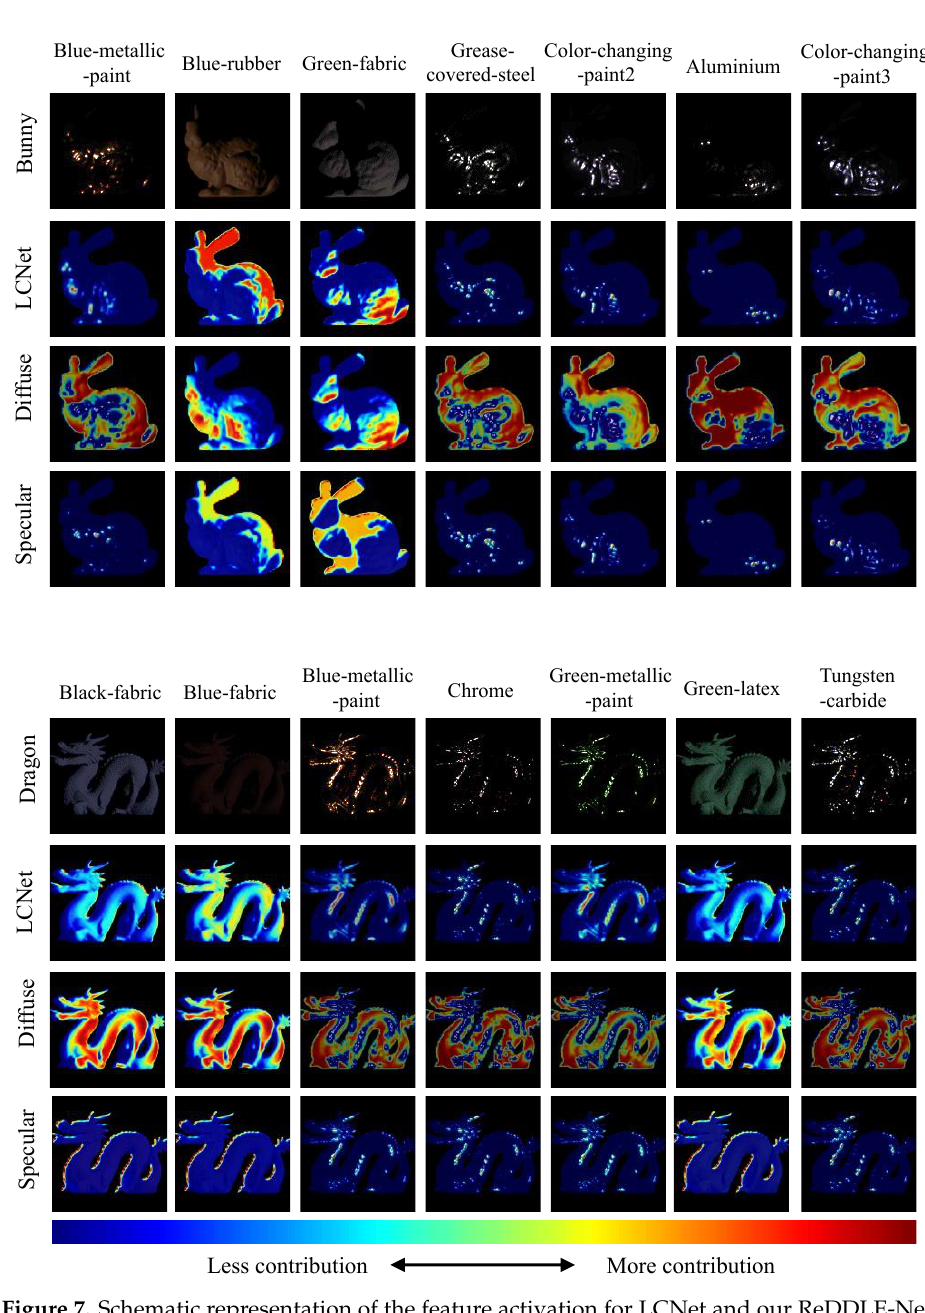
Figure 7. Schematic representation of the feature activation for LCNet and our ReDDLE-Net. The features in the red regions indicate more contributions, while blue regions indicate fewer contributions. The different columns represent the results of objects with different materials. Rows 1 and 5: Input images of eight Bunny and Dragon objects. The texts on the left indicate the names of the objects. Rows 2 and 6: Feature maps of LCNet [17]. Rows 3 and 7: Feature maps of our diffuse sub-network. The texts on the left indicate the name of our sub-network. Rows 4 and 8: Feature maps of our specular sub-network. The texts on the left indicate the name of our